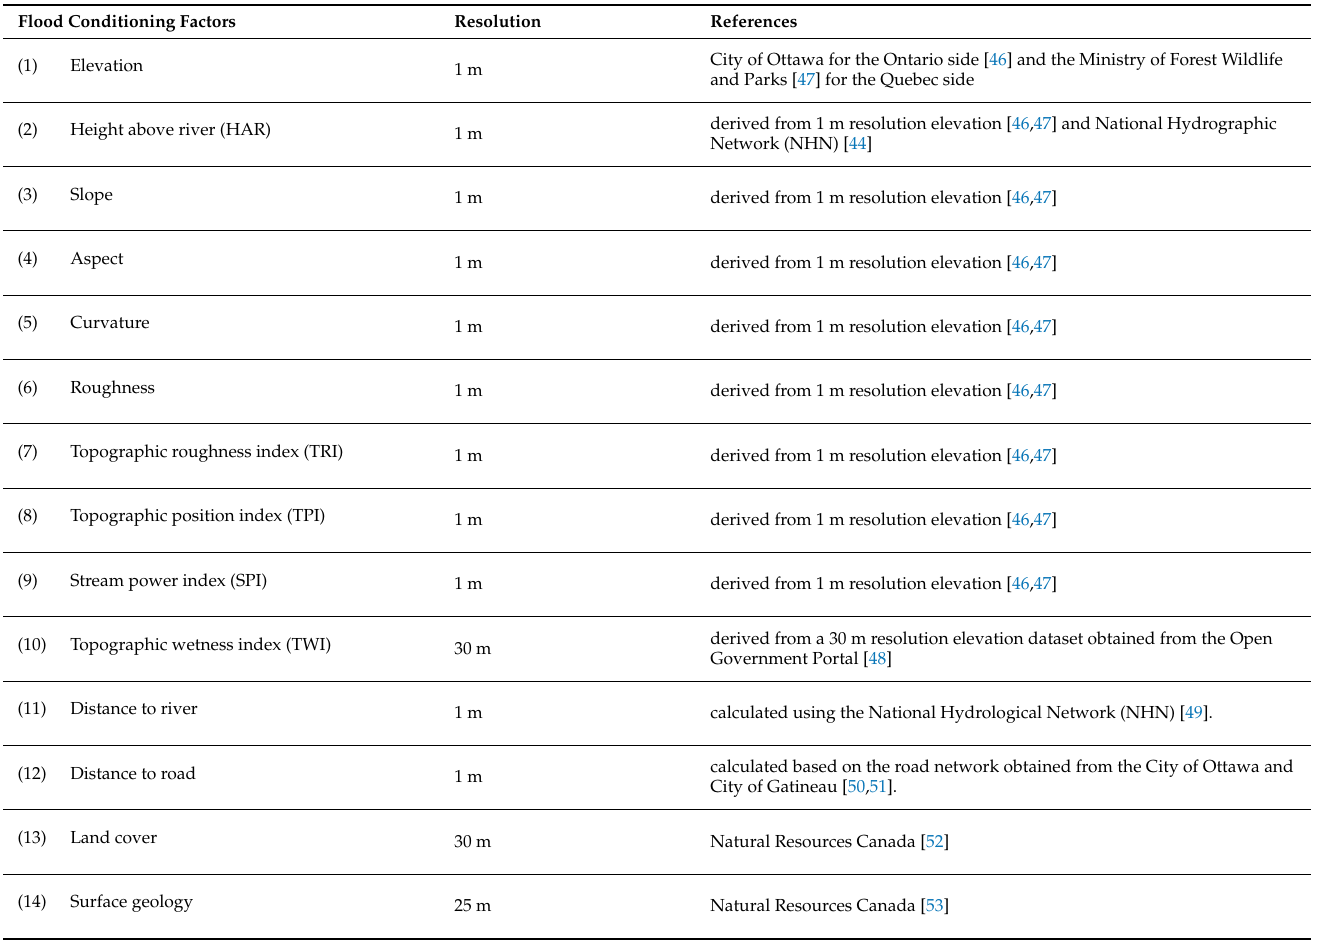
Table 1. Flood conditioning factors and their resolution and